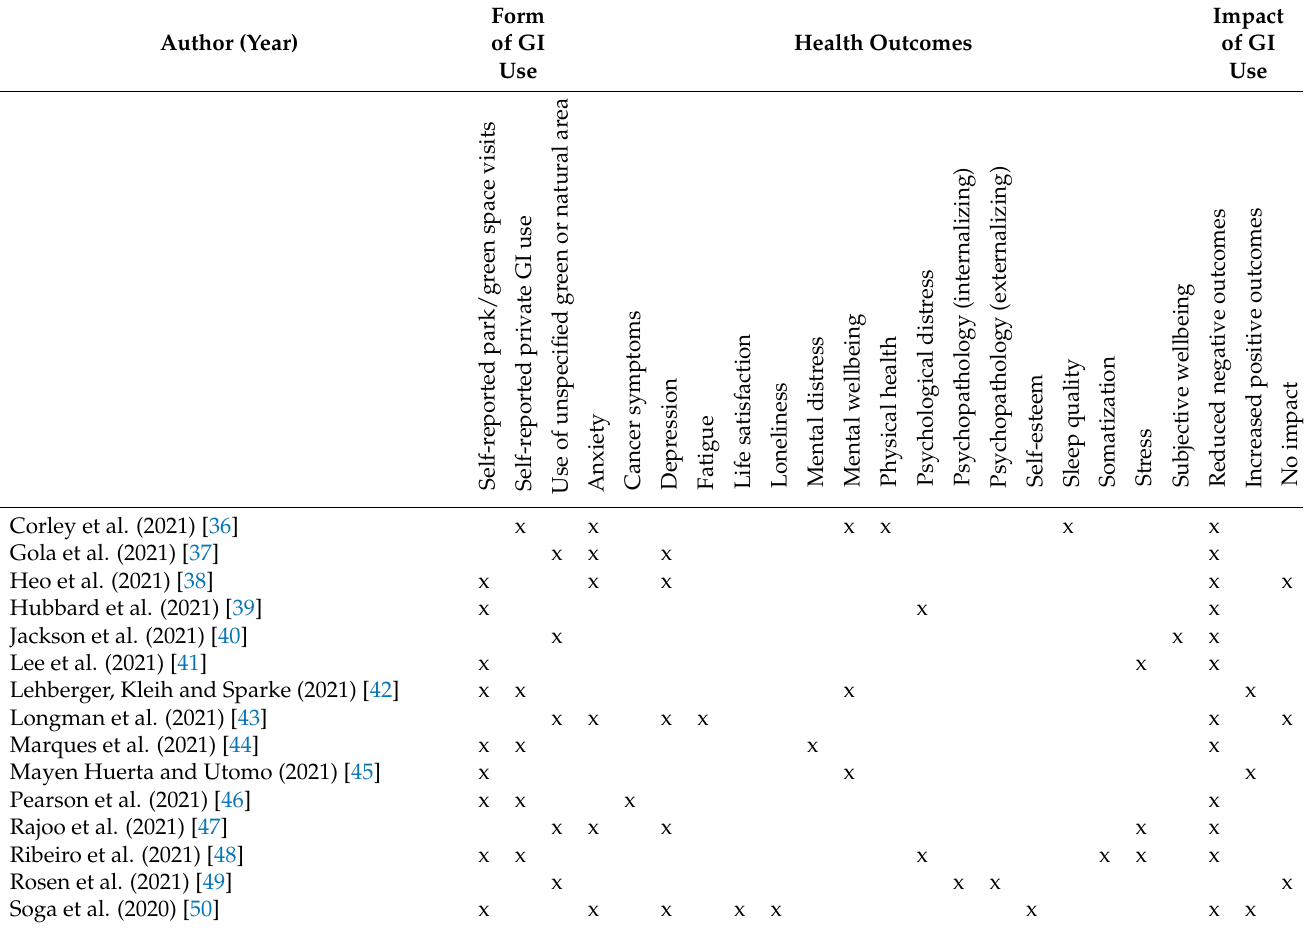
Table 2. Summary of articles identified in theme 2: the impacts of GI use on non-COVID health outcomes. Author (Year)